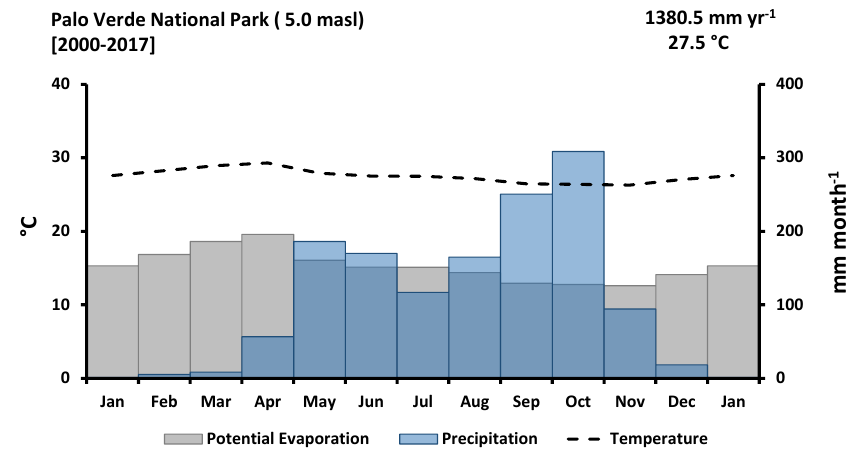
Figure 2. Climate diagram of Palo Verde National Park based on 18 years of measurements (2000–2017) of the meteorological station from the Organization for Tropical Studies in Palo Verde Research